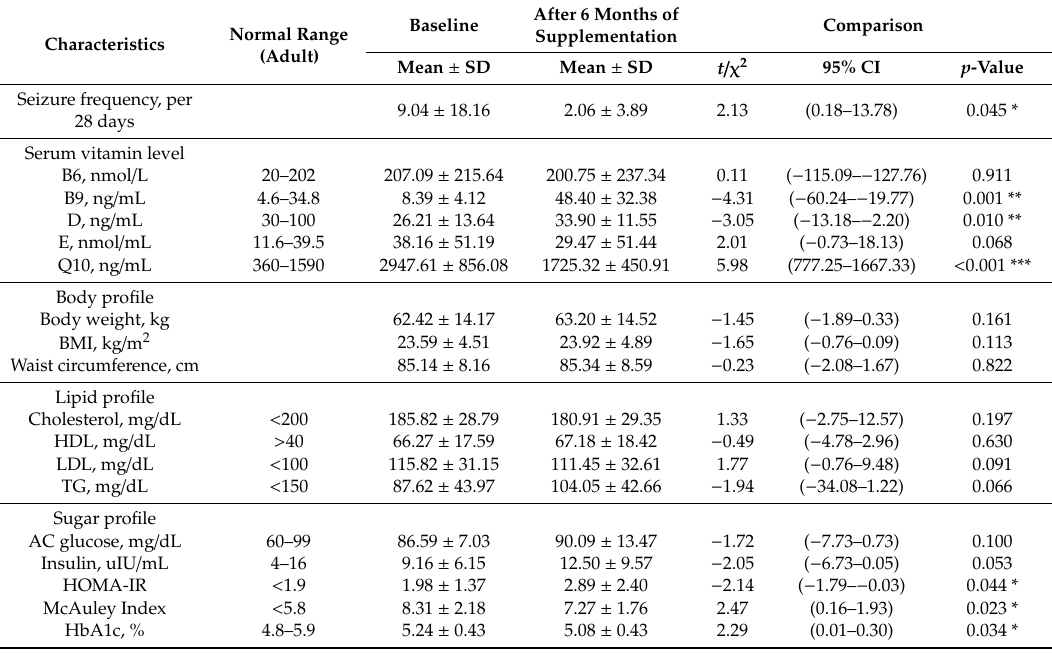
Table 2. Characteristics of the patients with intractable epilepsy at baseline and after 6 months of multivitamin supplementation ( n = 26).